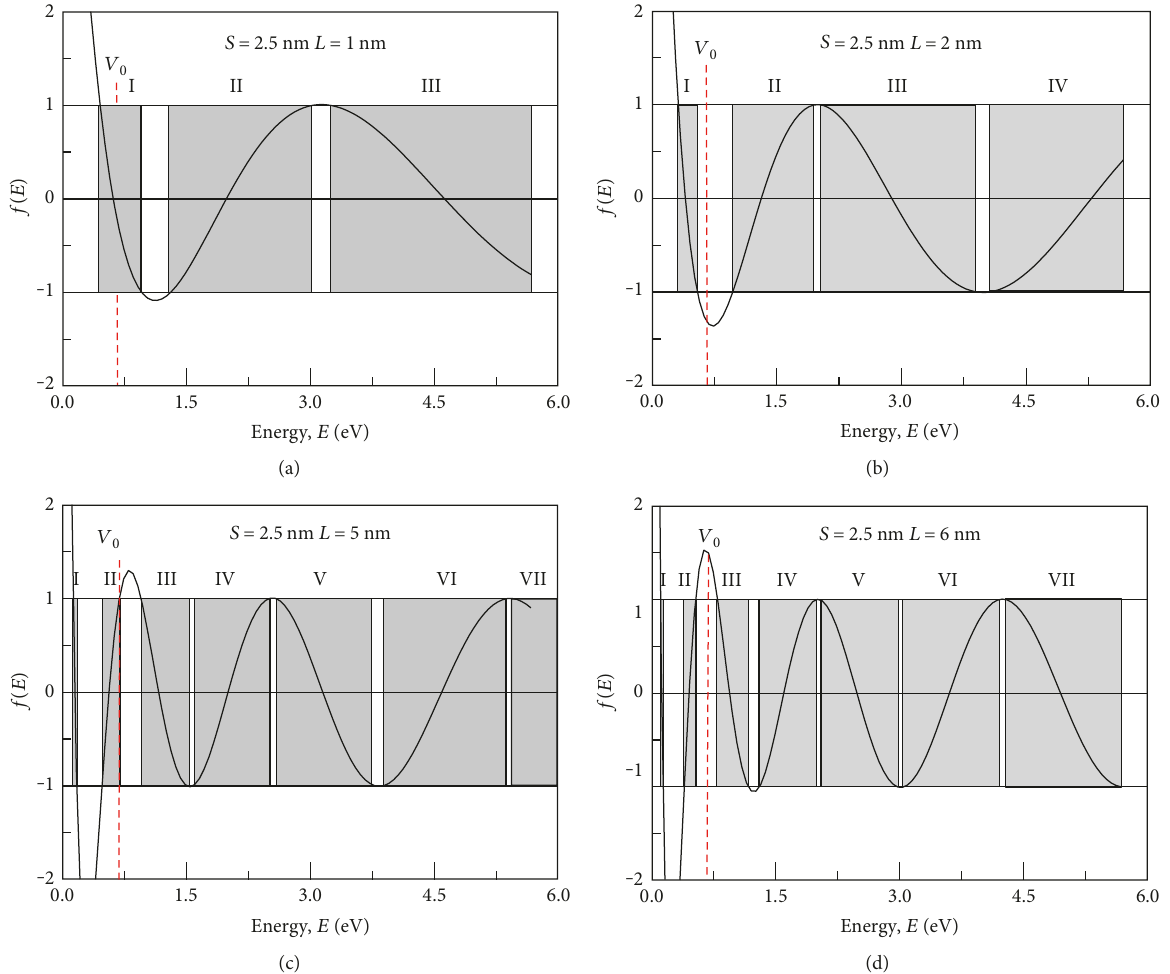
Figure 5: Miniband dispersion in In